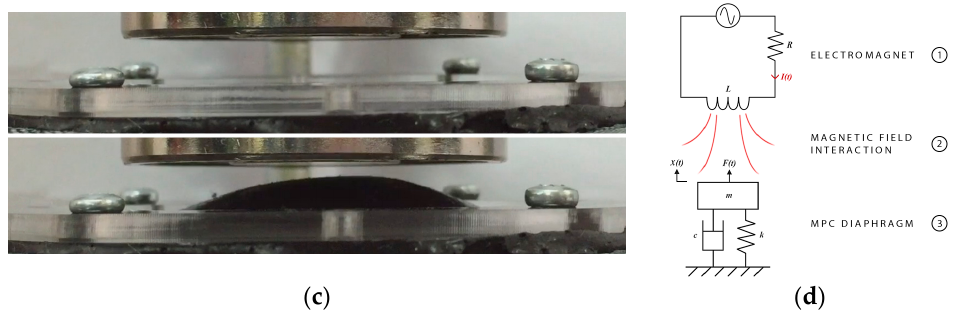
Figure 1. ( a ) The proposed actuator configuration, a pumping application is shown as an example; ( b ) Diaphragm displacement of the magnetic polymer composite; ( c ) Overview of the